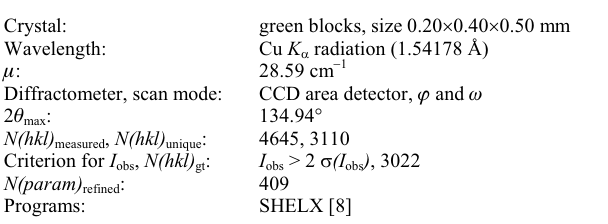
Table 1. Data collection and